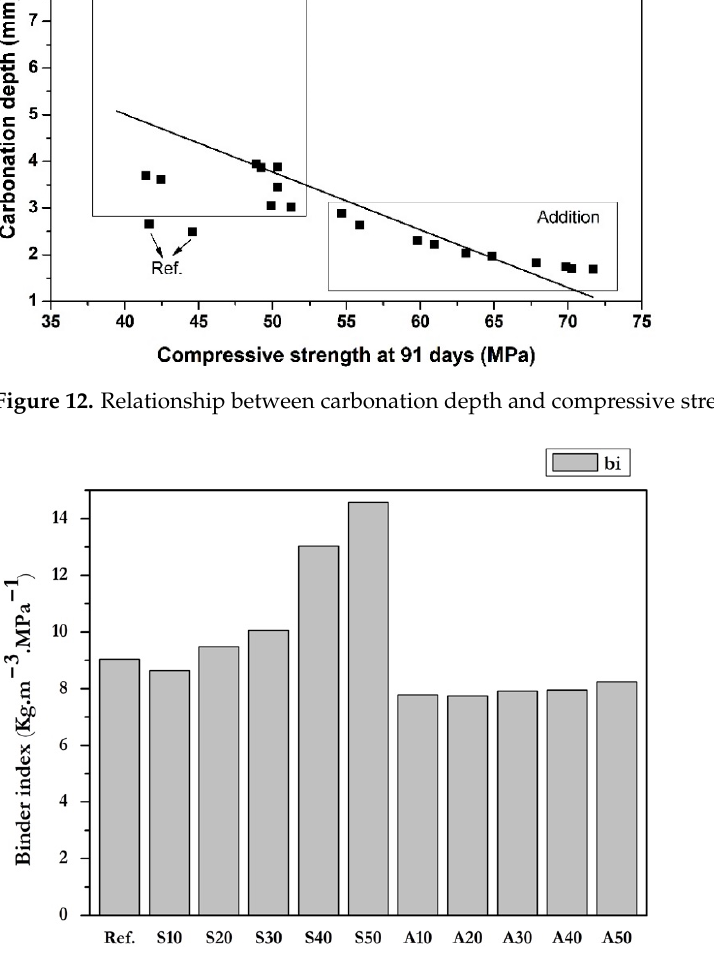
Figure 13. Binder index results.